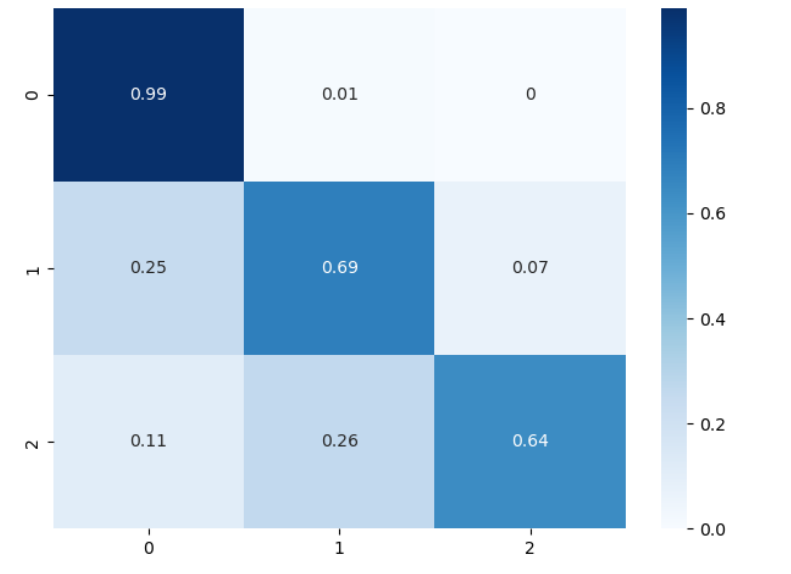
Figure 6. Normalized confusion matrix of well B.